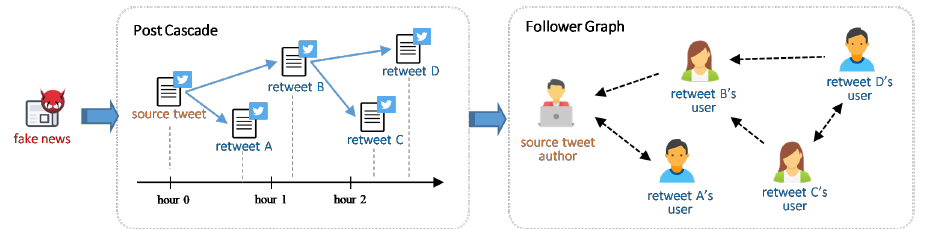
Figure 2. An example of fake news spreading on Twitter and follower graph converted from cascade